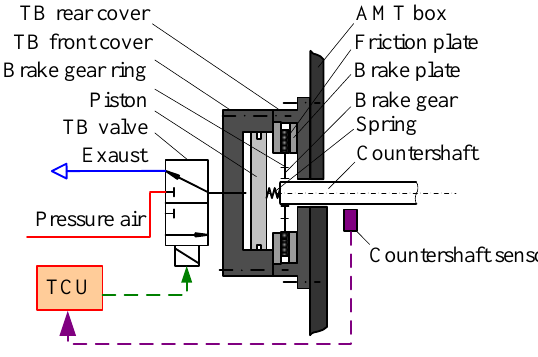
Figure 2. Schematic of the TB system. The TB solenoid valve is a high speed, on–off, normally closed solenoid valve. Com- pressed air enters the TB through the solenoid valve when the TCU gives instruction to the TB solenoid valve. The piston moves towards the brake plate under the pressure of compressed air, and the brake torque is created when the brake plate and the friction plate are compressed. The inner engaging ring of the friction plate is engaged with the outer engaging gear of the brake gear, and the countershaft begins slowing down under the action of brake torque.